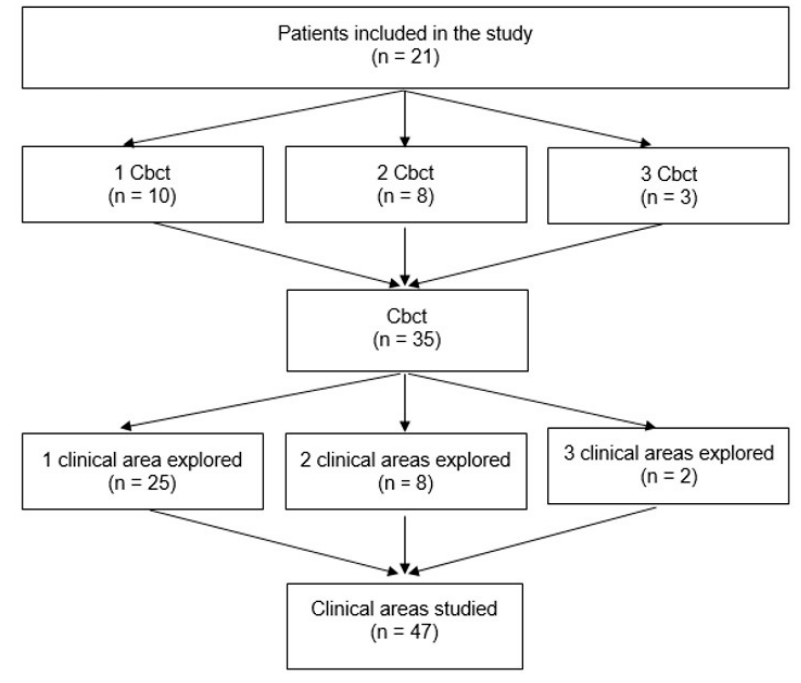
Figure 3. Number of clinical areas studied.